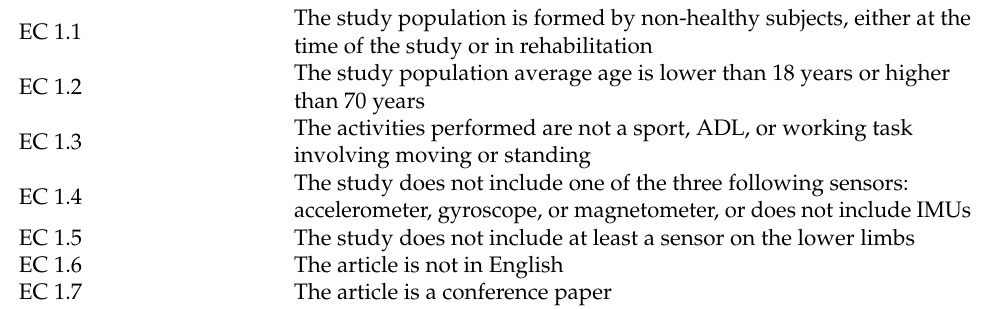
Table A2. Eligibility criteria (EC) during title and abstract screening phase. Articles were excluded